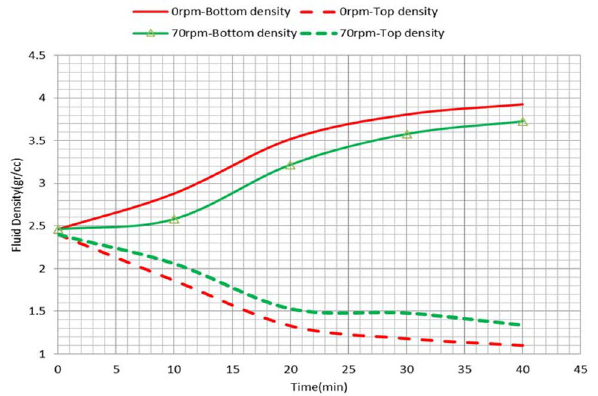
Fig. 6 Changes in the concentration of barite particles in the upstream and downstream of the circulating loop (flow rate of 0.190 l/s and deviation angle of